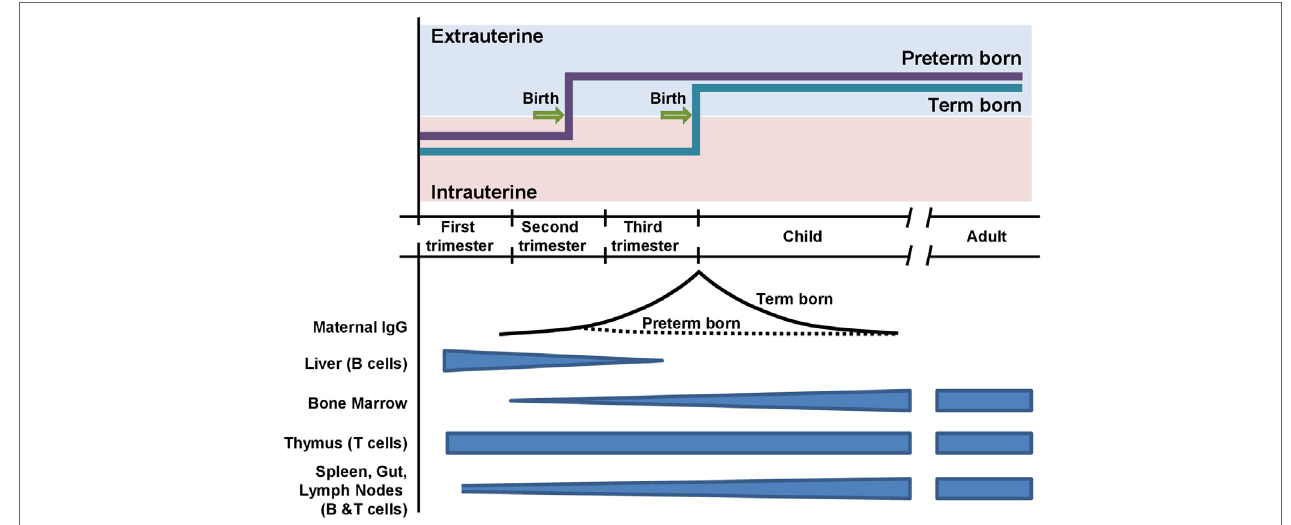
FigUre 1 | Timing of preterm and term birth in relation to the ontogeny of the adaptive immune system. Preterm neonates are exposed to extrauterine antigens before the completion of transplacental transmission of maternal